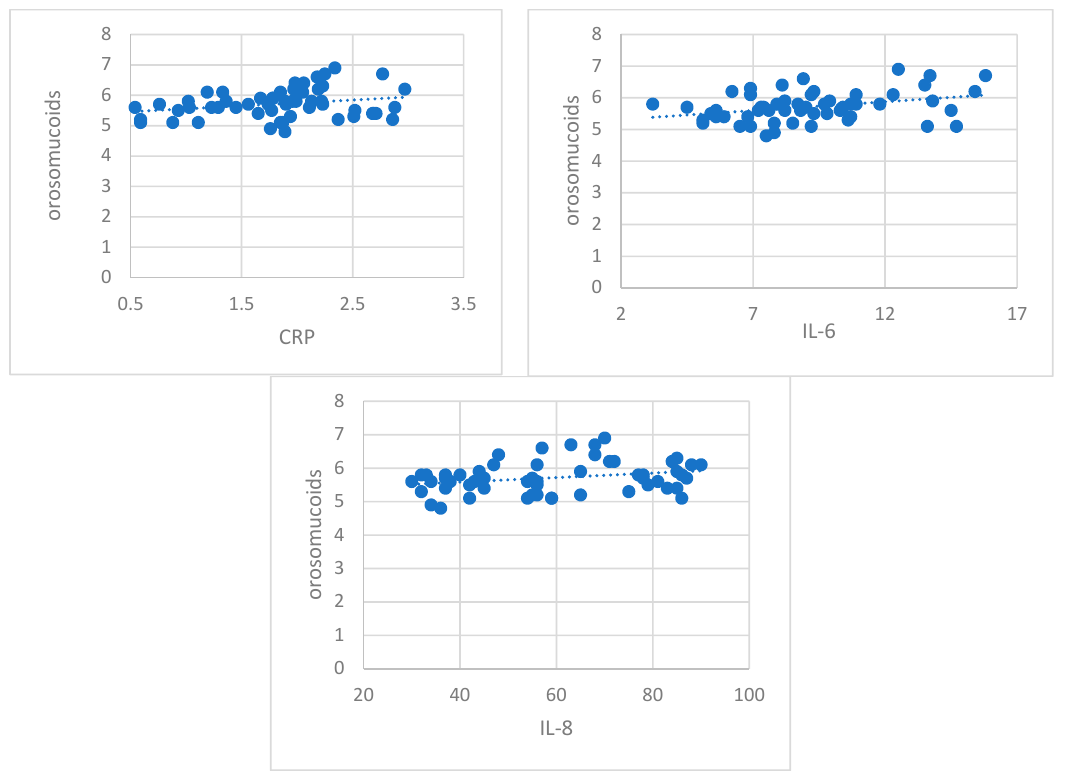
Figure A2. Orosomucoids and CRP, IL-6, and